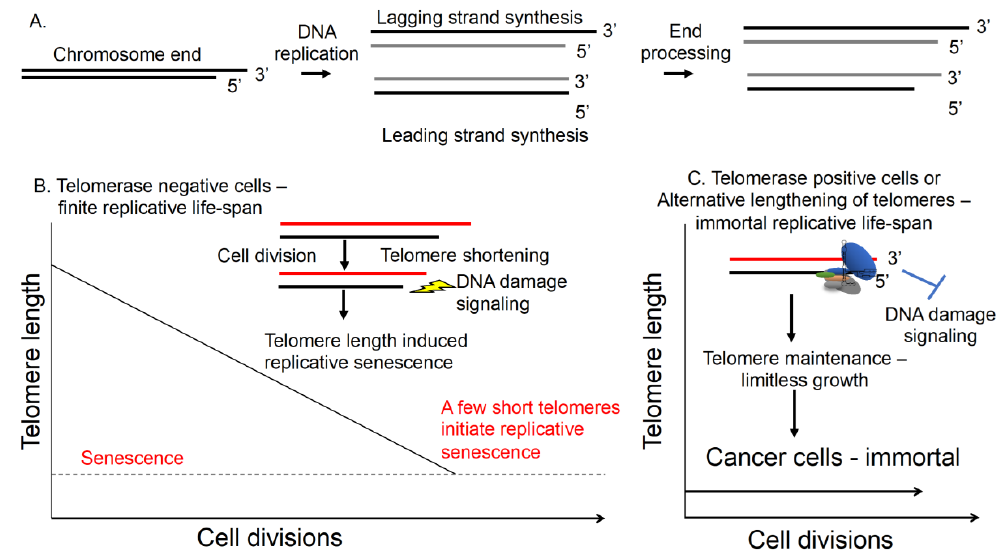
Figure 1. Telomere biology. ( A ) Telomeres are replicated during cell division (mitosis). A set of enzymes process the end of replicated chromosomes so that a 3 (cid:48) G-rich overhang is produced. The single stranded 3 (cid:48) end displaces the double-stranded structure to form a three-stranded structure (D-loop). Shelterin binds to both the single- and double-stranded portion of the telomere, protecting it from being recognized by the DNA damage machinery, solving the “end-protection” problem. ( B ) Telomerase negative cells or cells without a telomere maintenance mechanism. Due to the “end-replication” problem, a small piece of DNA at the lagging strand end of DNA is not replicated and is lost from the chromosome that is passed on to the daughter cells. Over time, this slow erosion results in the loss of telomere length. When a few telomeres have DNA damage at chromosome ends, deprotection occurs and cellular senescence is initiated. This removes cells with critically short telomeres from the replicating population of cells and acts as a potent block to tumor progression. ( C ) Cells become replicatively immortal by adopting a telomere maintenance mechanism. Telomeres are maintained by two mechanisms, telomerase RNP or a homology-directed mechanism called alternative lengthening of telomeres. Telomerase is the mechanism that approximately 90% of human cancer cells use to maintain telomeres and immortality. In male germline cells, telomeres are also maintained or elongated by the ribonucleoprotein